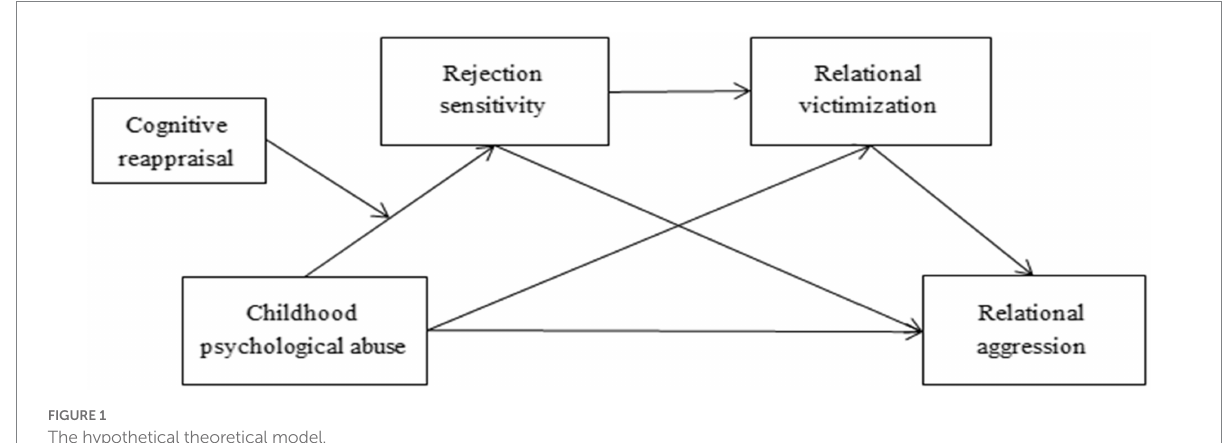
FIGURE 1 The hypothetical theoretical